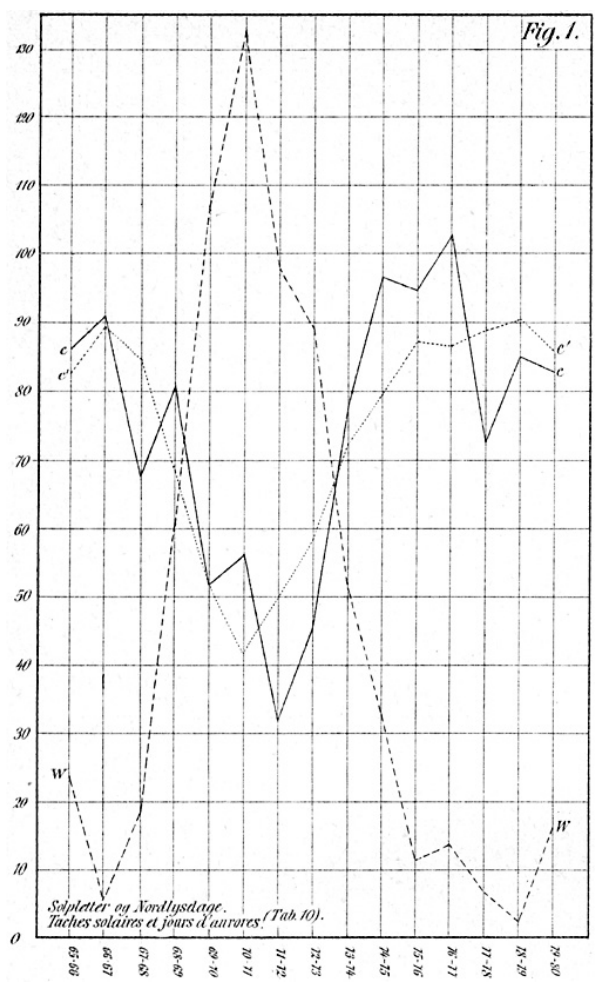
Figure 10. Relations between Wolf’s sunspot number (dotted line) and no. of auroral nights (heavy line). Thin line indicates equivalent values of auroras (Tromholt,